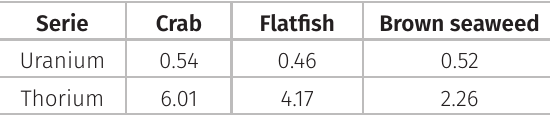
Table VI. Dose conversion coefficient for external exposure due to gamma radiation, in (nGy.d -1 )/(kBq. kg -1